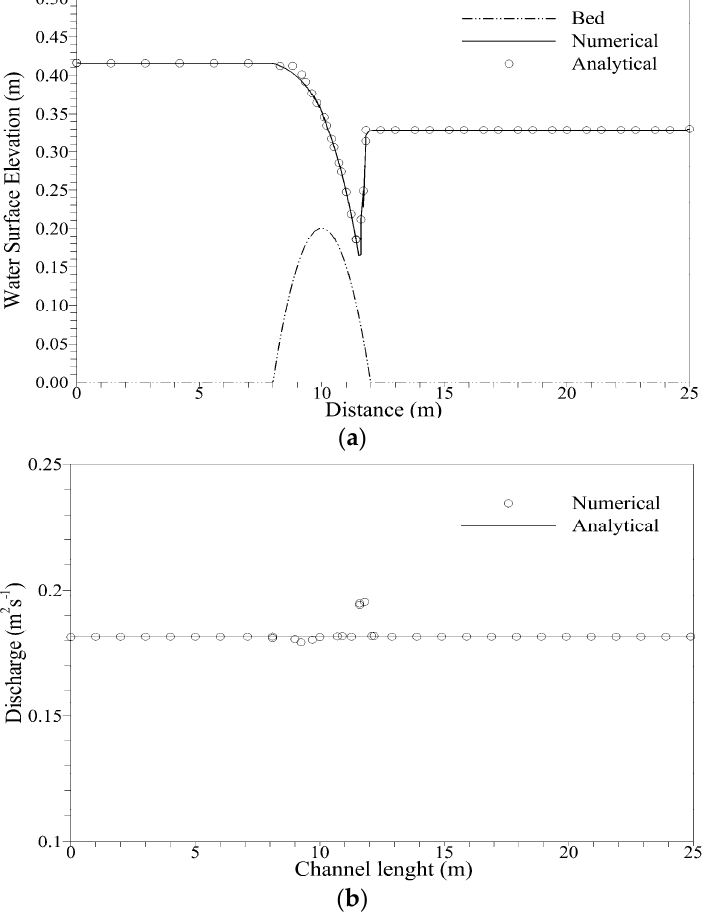
Figure 8. Comparison of water surface elevation ( a ) and discharge ( b ) for transcritical flow with a shock.